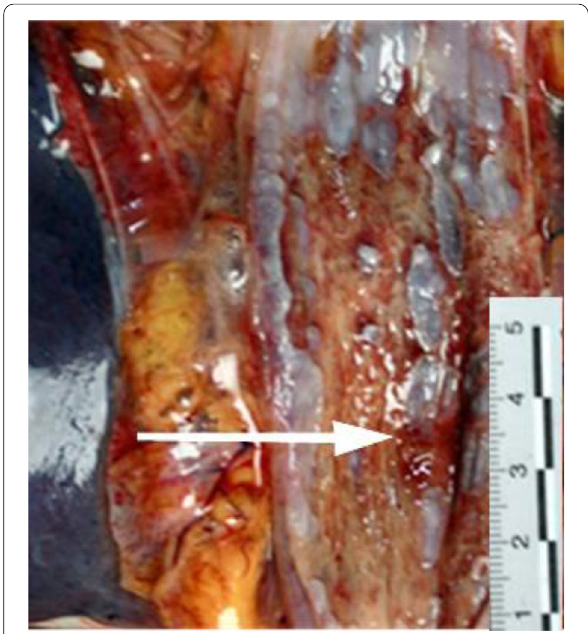
Fig. 1 Longitudinally dissected esophagus showing the mucosal surface with longitudinally placed ulcers indicated with a white arrow at the level of the lower